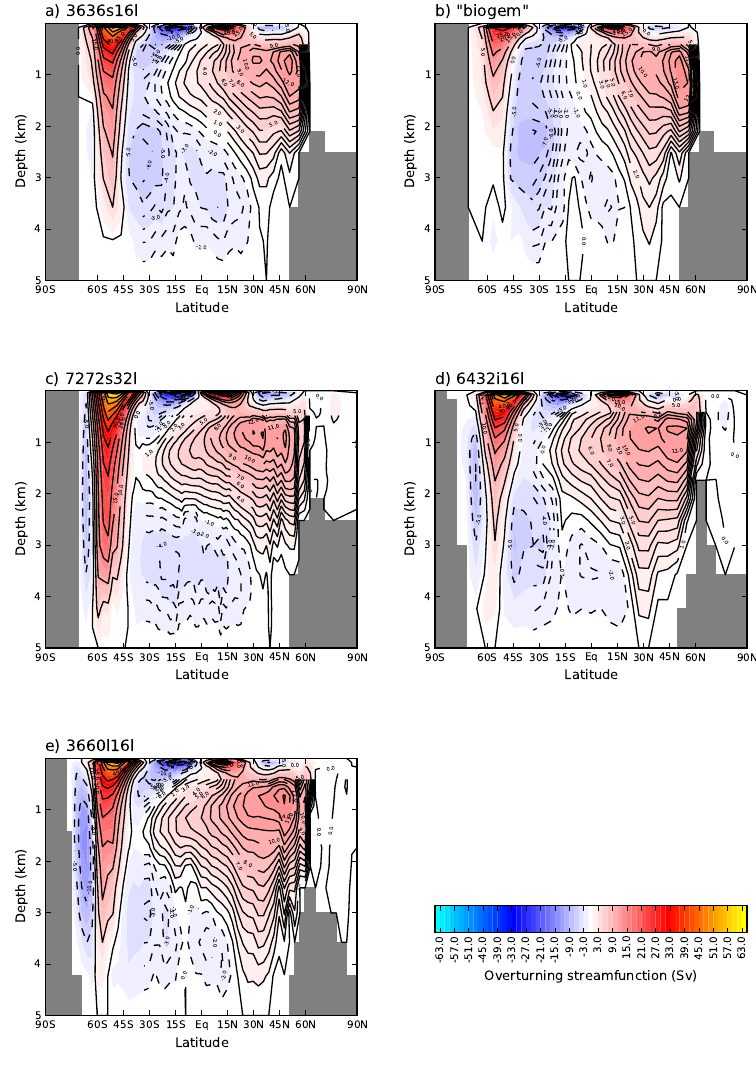
Fig. 20. Global meridional overturning streamfunctions (Sv) in the five experiments. Contour interval below around 500m depth and north of 30 ◦ S is 1Sv, outside this region